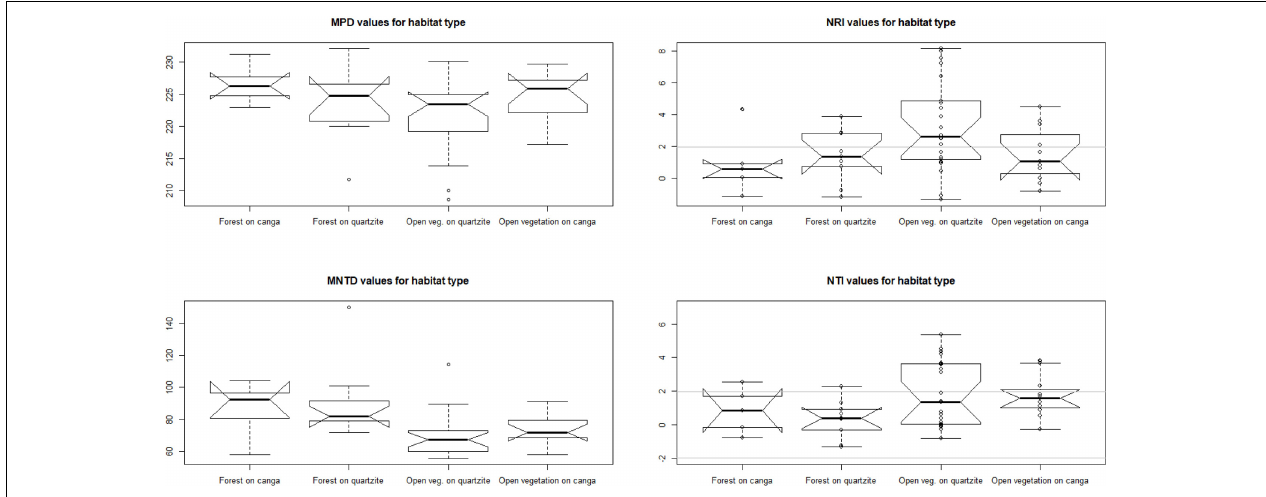
FIGURE 6 | Values of MPD, MNTD and their standardized metrics comparing the observed values against a null model: the NRI and NTI, respectively. Individual sites (dots in the boxplots) with values of NRI and NTI above +1.96 (gray lines) are statistically phylogenetically clustered.